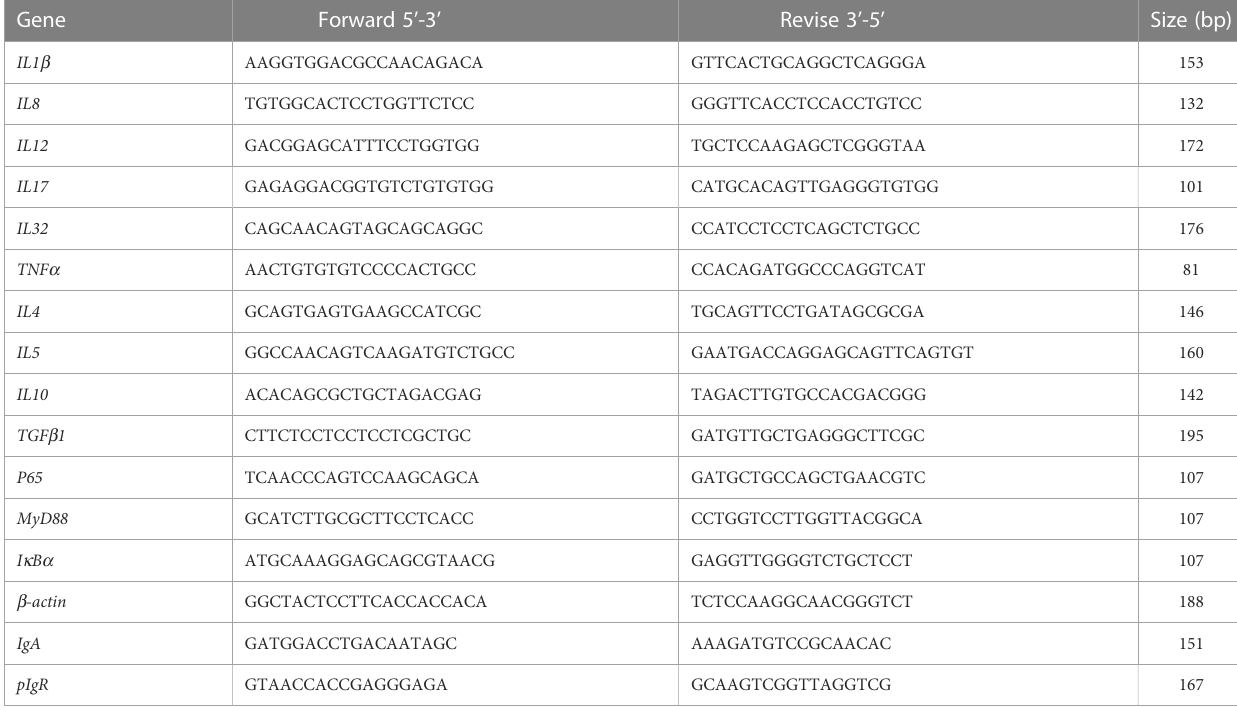
TABLE 2 PCR primers for mRNA expression of intestinal immune-related genes in grouper. Gene Forward 5 ’ -3